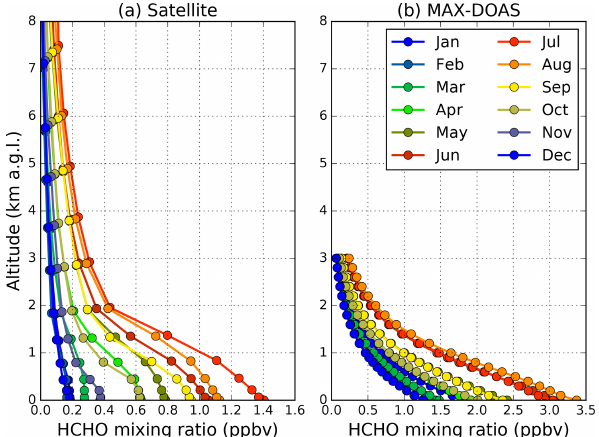
Figure 14. Tropospheric HCHO VCDs measured by TROPOMI spatially averaged with different radii surrounding the MAX-DOAS measurement